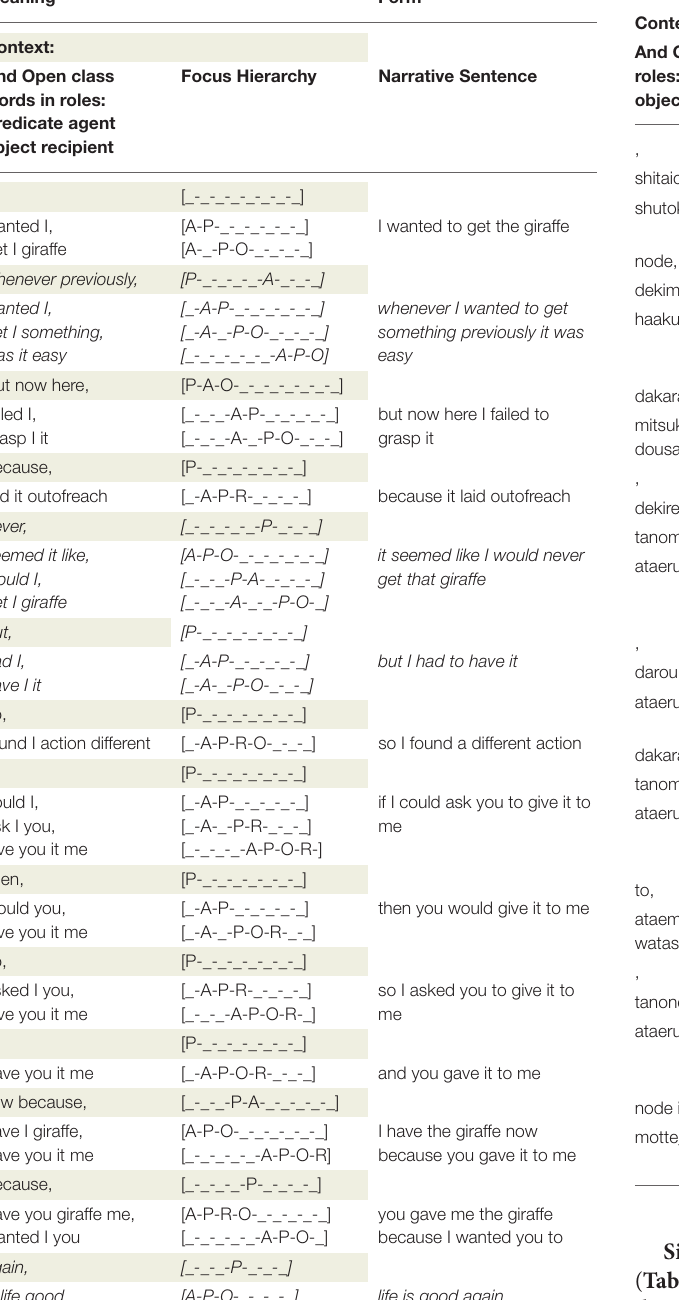
TABLE 10 | Form and meaning poles of a set of sentences making up a narrative construction in Japanese. Meaning Form Context: